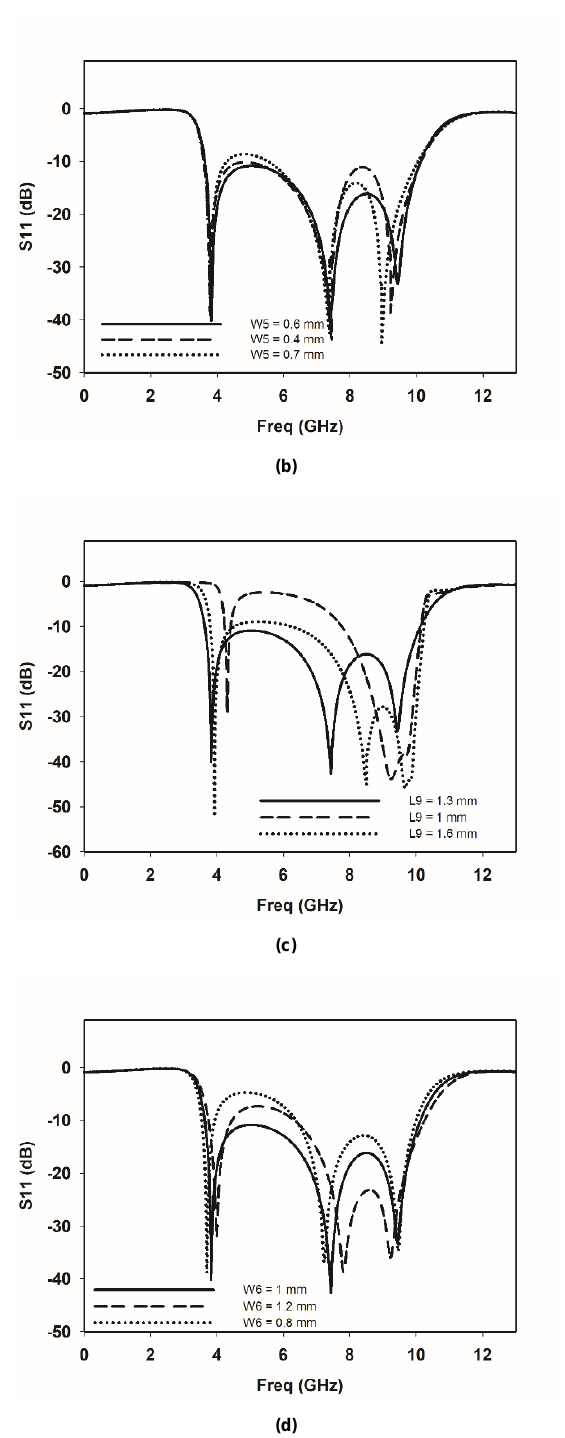
FIGURE 6. The effect of: (a) Length of U ‐ shaped resonators, (b) Width of rectangular slot, (c) Length of rectangular slot (d) Width of CPW line. As shown in Figure 6(a) to adjust the bandwidth frequency, the L6 value has been changed from 1.5 to 2.1 mm. L6 is found to be 1.9 mm to cover the UWB frequency band (3 – 11 GHz) with good adaptation. To improve impedance matching,